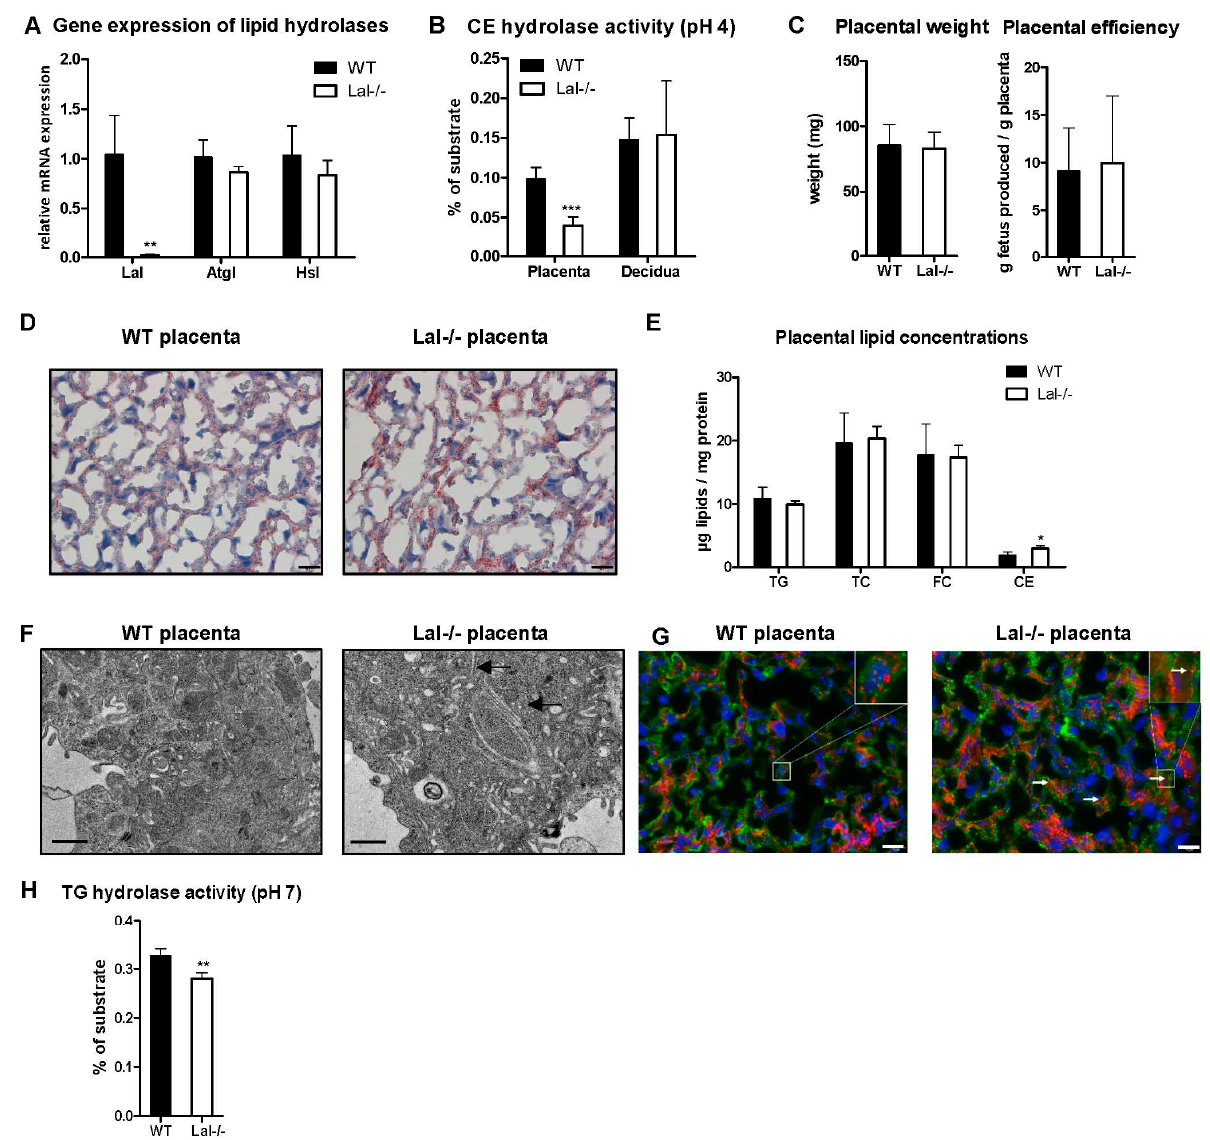
Figure 3. Lysosomal acid lipase (LAL) deficiency alters placental lipid homeostasis in utero. Placentas were isolated from WT and Lal-/- mice on day 19 of pregnancy. ( A ) Gene expression of lipases in the placenta. ( B ) Acid CE hydrolase activity in placenta and decidua. ( C ) Placental weight and efficiency ( n = 26 WT, 34 Lal-/-). ( D ) ORO staining of cryosections from placental tissue. Magnification, 40×; Scale bar, 20 µm. ( E ) Placental lipid concentrations. ( F ) Electron micrographs of WT and Lal-/- placenta; black arrows indicate CE crystals. Scale bar, 1 µm. ( G ) Immunofluorescence double staining for neutral lipids (ORO, red), lysosomes (LAMP1, green), and nuclei (DAPI, blue) in the placenta; white arrows indicate lipids co-localizing with lysosomes. Magnification, 40 × ; scale bar, 20 µ m. ( H ) Neutral TG hydrolase activity. Data represent mean values + SD from different dams ( n = 4). Statistically significant differences were calculated by two-tailed Student’s t -test; * p < 0.05, ** p ≤ 0.01, *** p ≤ 0.001.